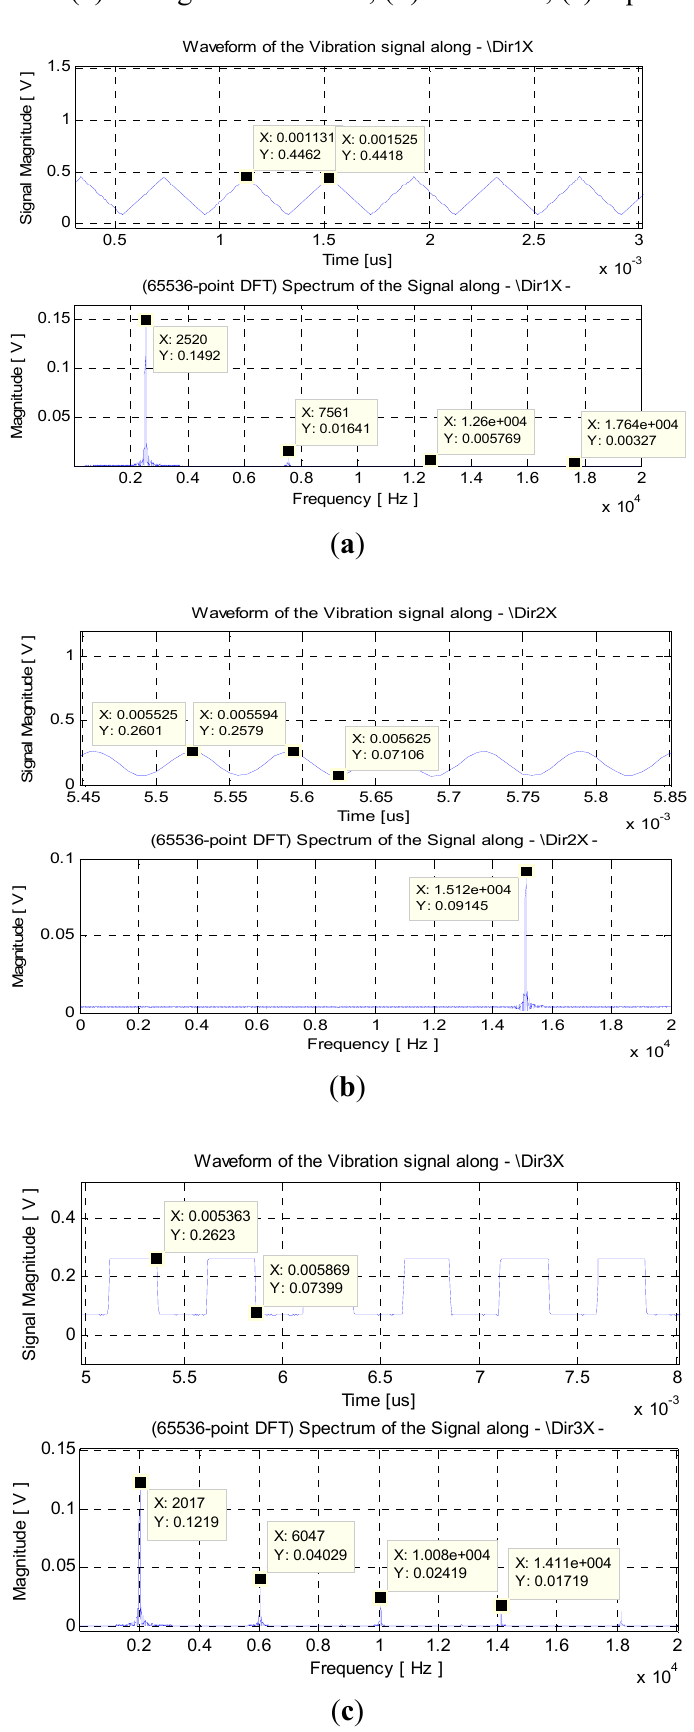
Figure 11. ( a ) Triangular waveform; ( b ) Sinewave; ( c ) Square